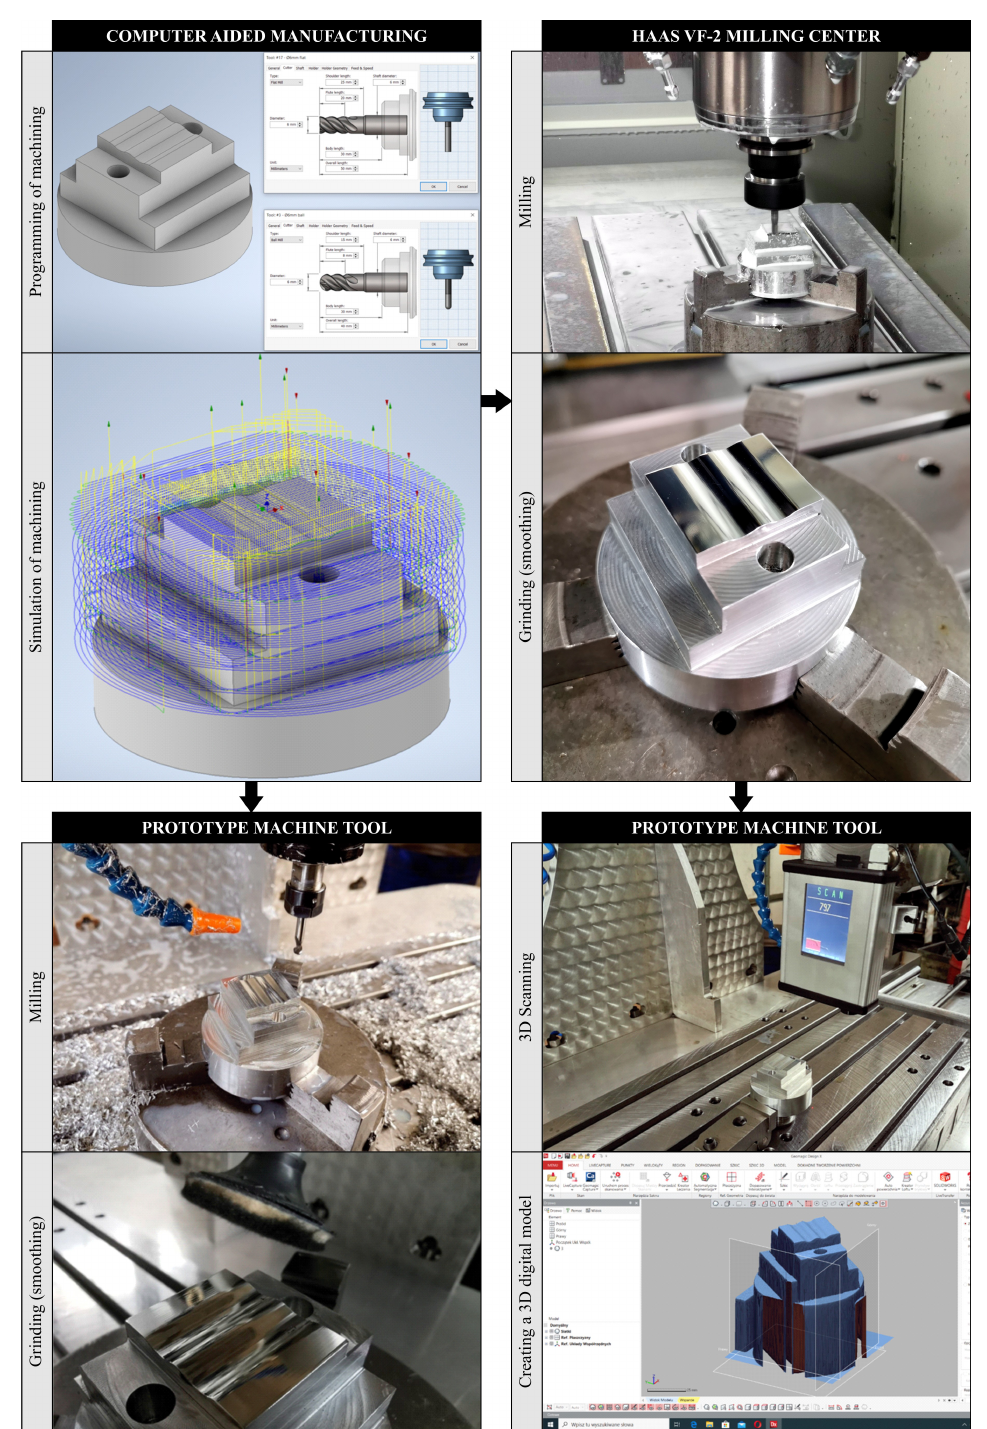
Figure 3. Graphical representation of the stages of experimental research methodology in the field of operations leading to the preparation of test pieces.